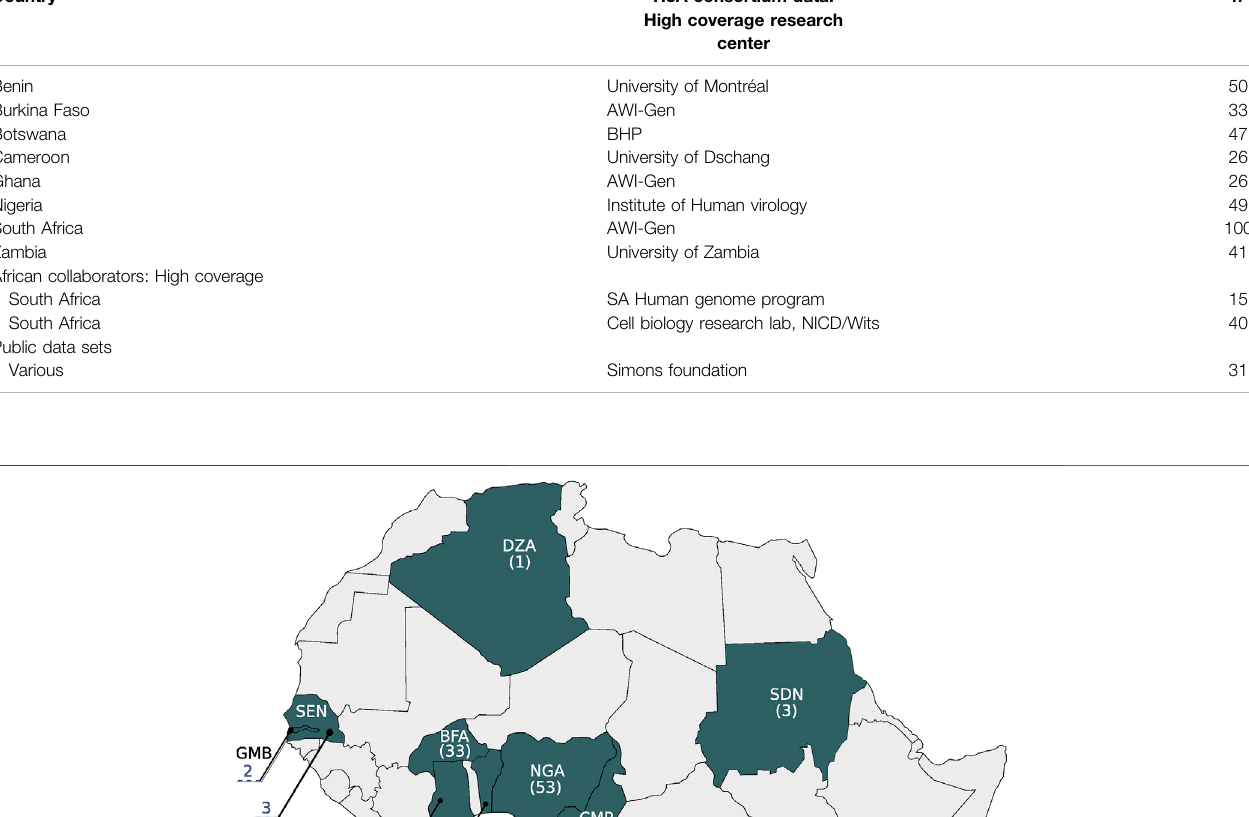
Frontiers in Pharmacology |